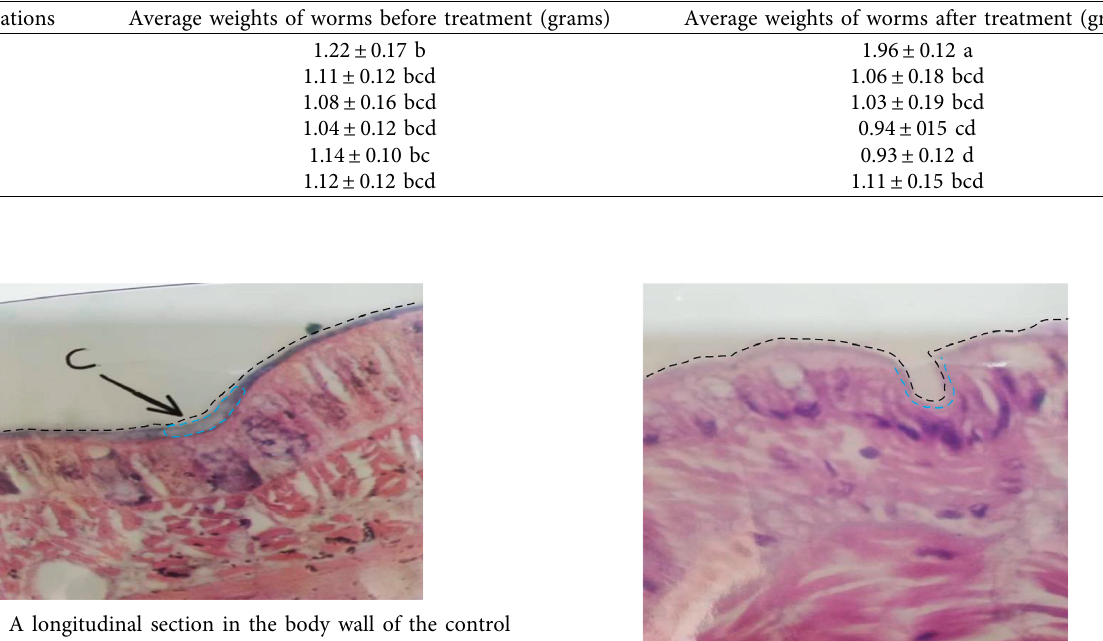
Figure 2: A longitudinal section in the body wall of worms exposed to a concentration of 10 ppm in which the cell boundaries are shrunken and indistinctly defined by the epidermal epithelial tissue (H and E) stain magnification